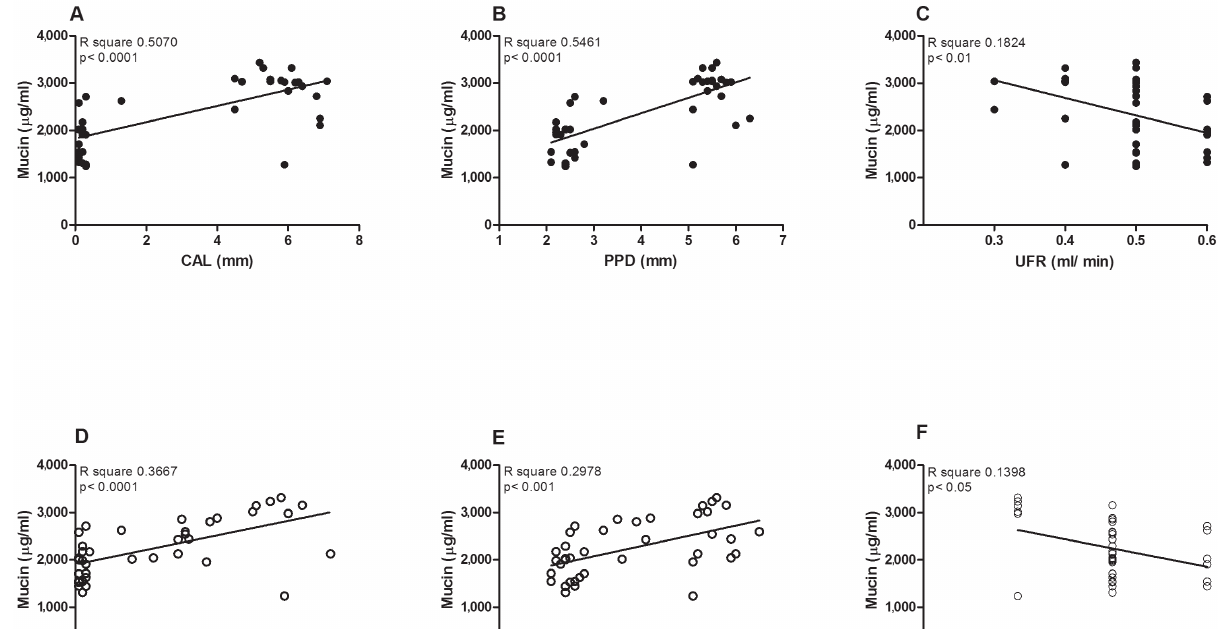
Figure 5- Pearson’s correlation analysis between mucin and clinical attachment level (CAL) (A and D), probing pocket depth (PPD) (B and E) and unstimulated flow rate (UFR) (C and F) in aggressive periodontitis (AgP) (upper panel) and chronic periodontitis (CP) (lower panel) groups